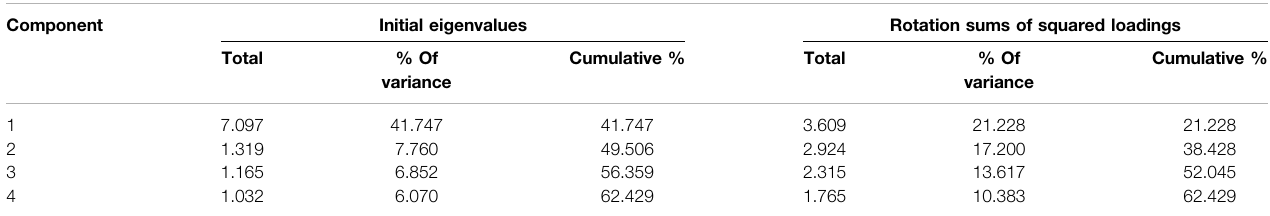
TABLE 6 | Total variance explained.